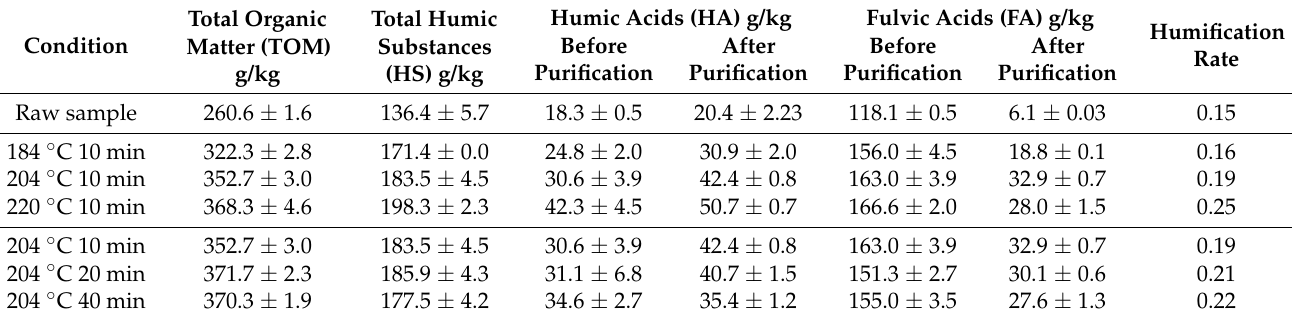
Table 2. TOM, HS, HA, and FA content of raw broccoli and SE